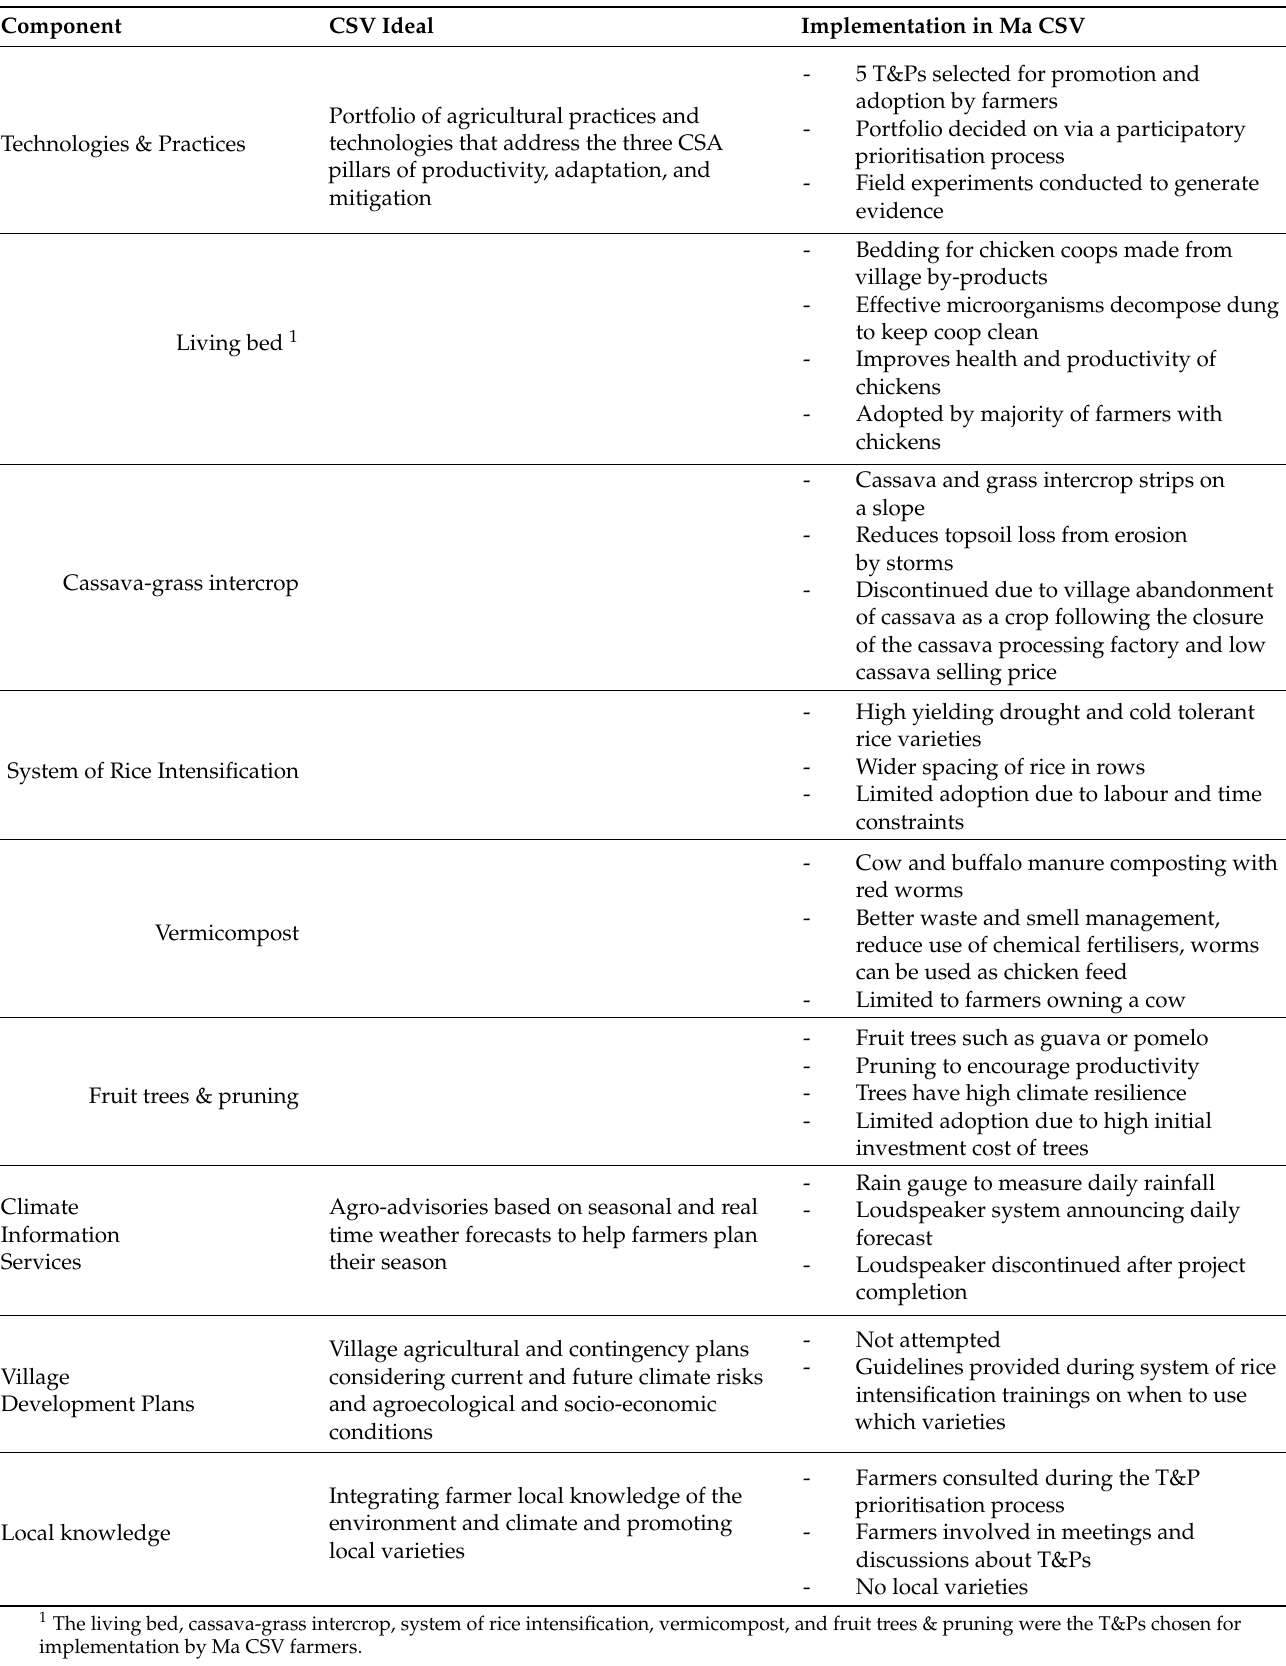
Table 2. Components of an ideal Climate-Smart Village and their level of implementation in Ma